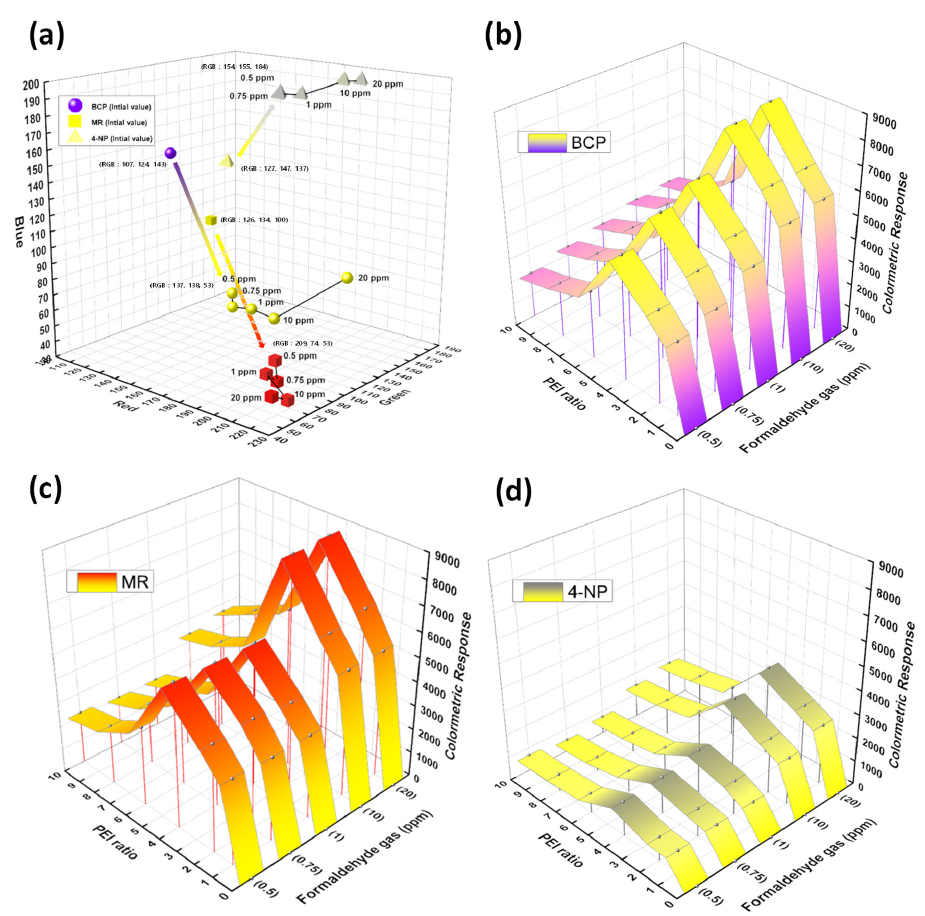
Figure 4. ( a ) Color changes observed for BCP, MR, and 4-NP colorimetric sensors when exposed to 0.5–20 ppm formaldehyde. Colorimetric response ( ∆ RGB values) of ( b ) BCP, ( c ) MR, and ( d ) 4-NP